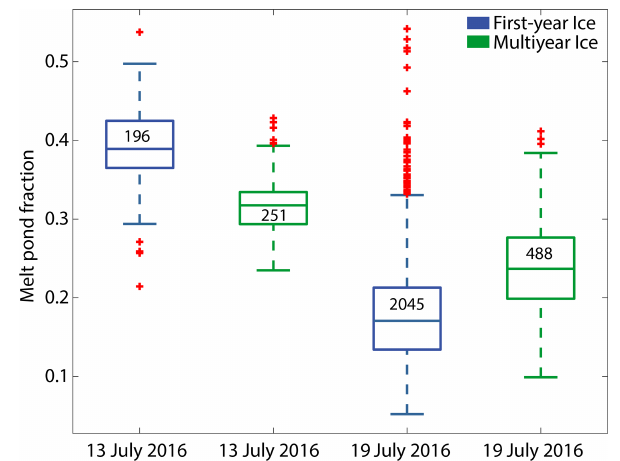
Figure 8. Melt pond statistics from two flights that contain both first-year and multiyear ice. In the 13 July 2016 case, multiyear ice has a lower pond fraction, while in the 19 July 2016 case the first- year ice has a lower pond fraction. Blue corresponds to first-year ice statistics, green to multiyear ice statistics, and red crosses indicate outliers. The number of image frames used to calculate statistics for each flight is included inside the box. The approximate area of each image frame is 0.25km 2